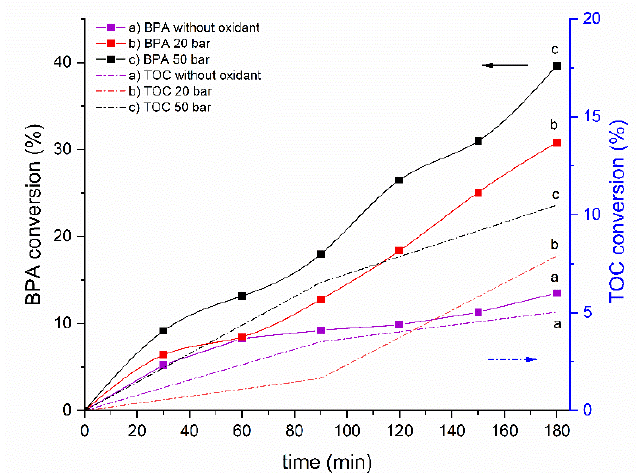
Figure 3. BPA and TOC conversion as a function of reaction time in non-catalytic